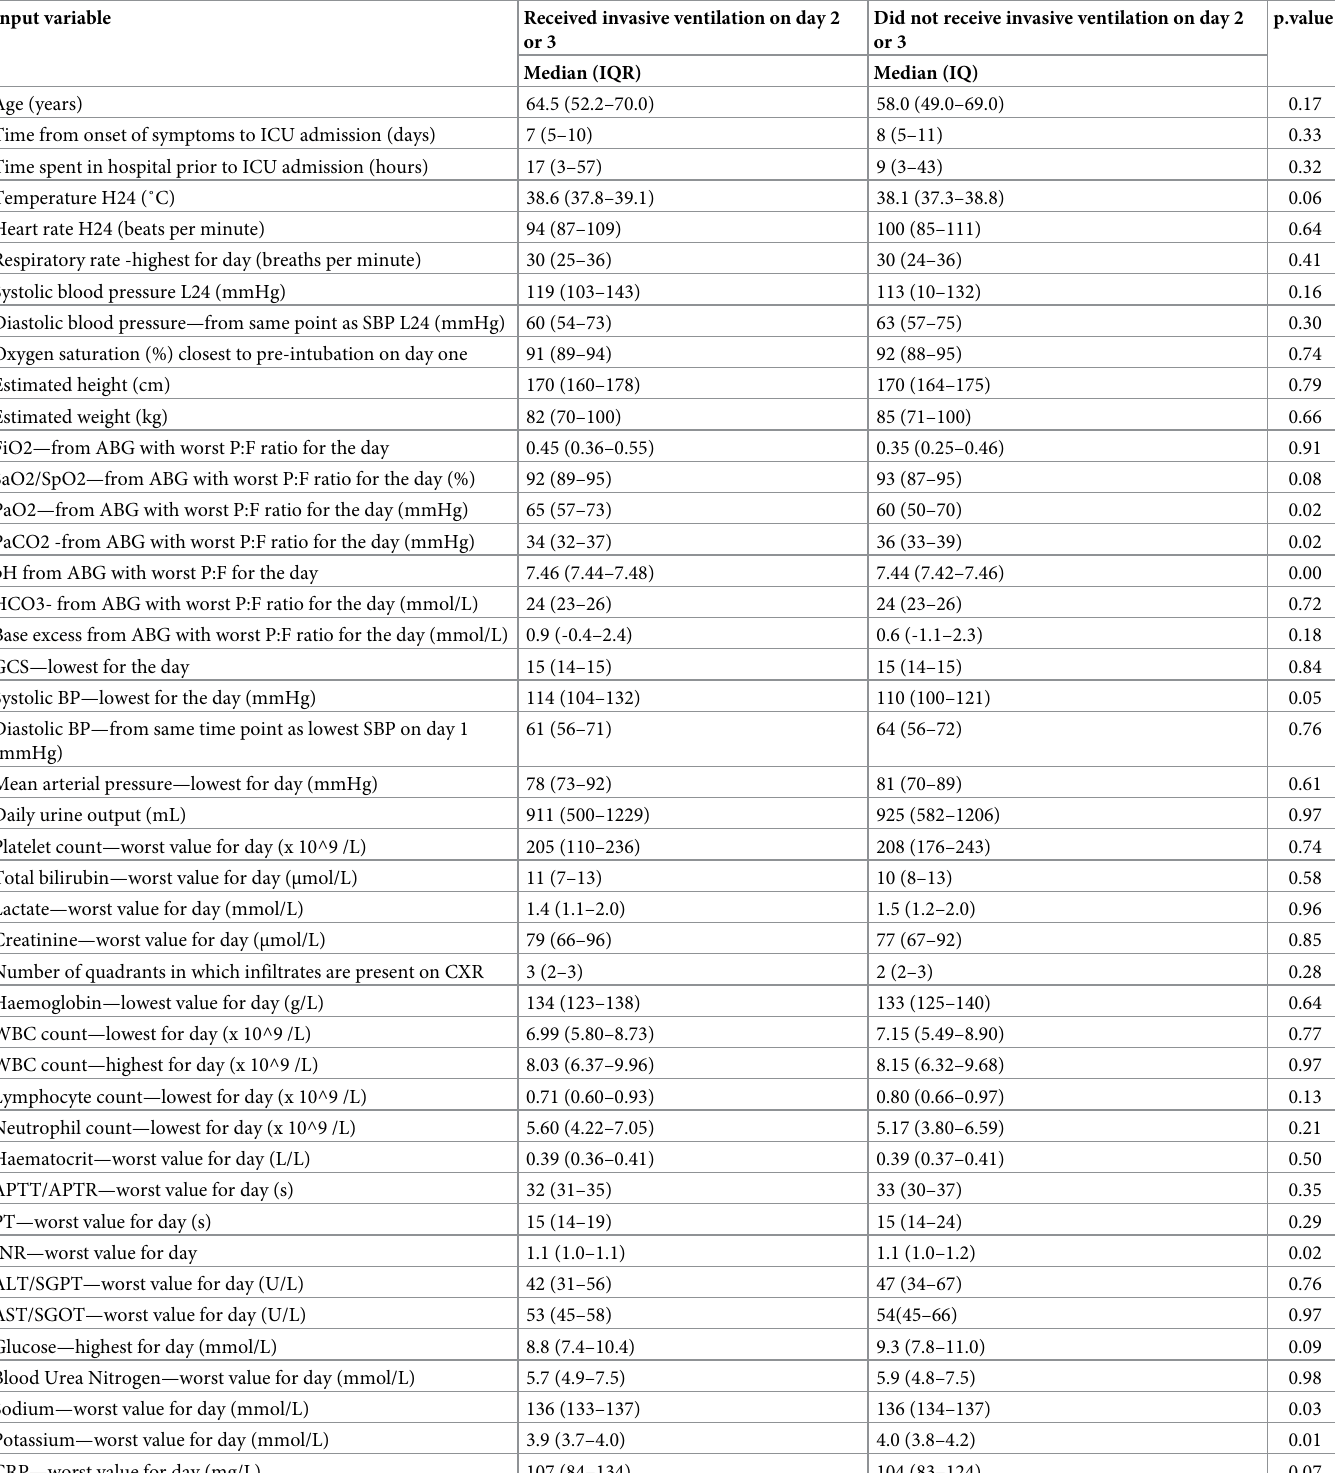
Table 2. Continuous input variables’ population characteristics and corresponding p-value (Welch Two Sample